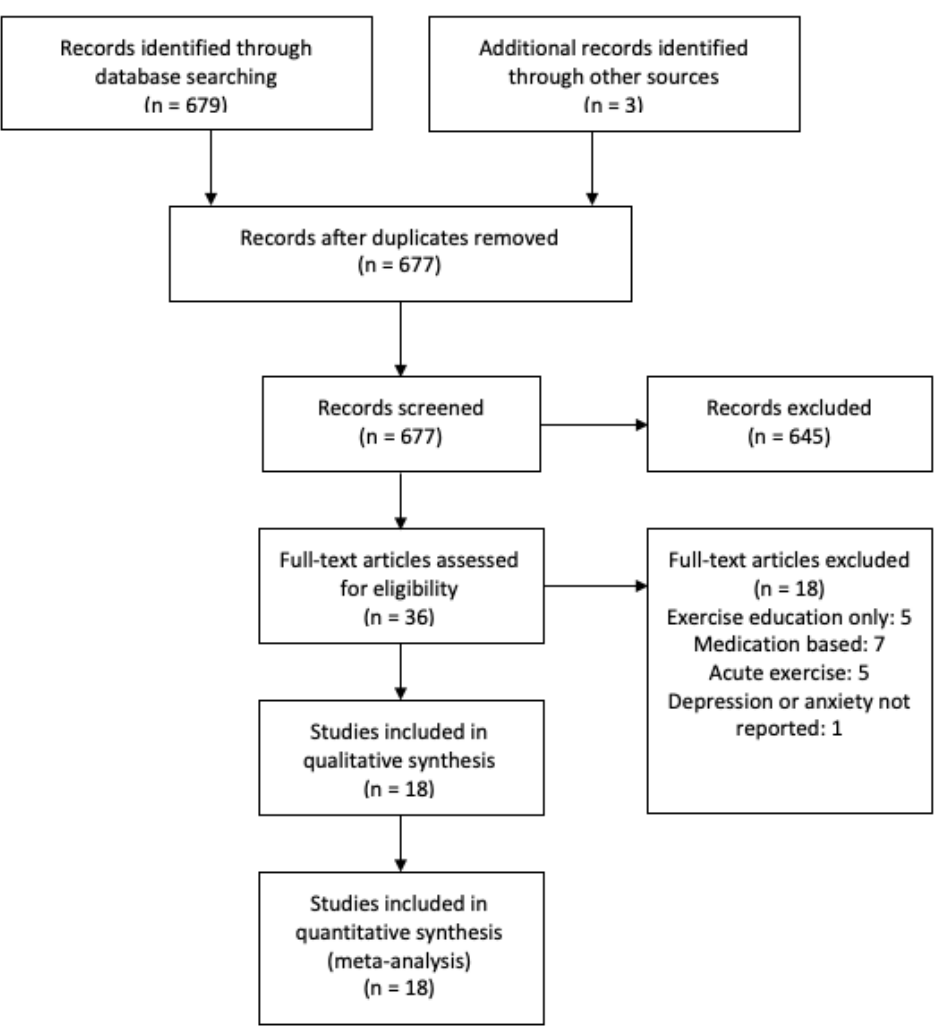
Figure 1. Process of publication selection.